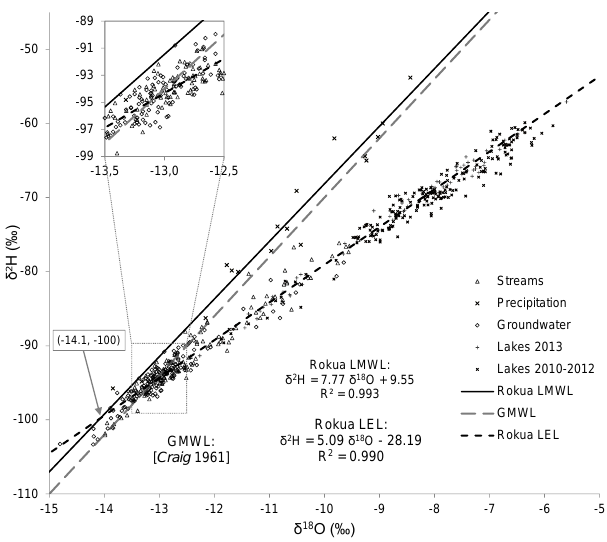
Figure 4. δ 2 H- δ 18 O relationship for different appearances of sur- face water (lakes, streams) and groundwater in the study area, inves- tigated within the scope of this study. The Rokua evaporation line (local evaporation line – LEL) was defined as the best fit line of the data points representing lakes sampled during the July–August 2013